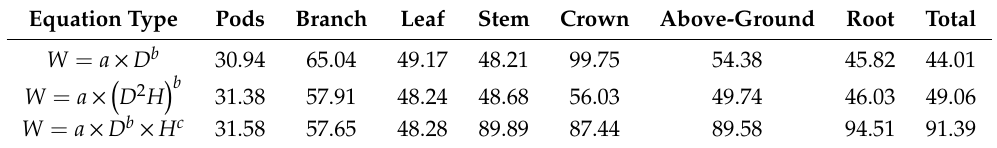
Table 2. Information statistic ( ∆ AICc) of the likelihood analysis for three allometric biomass equations. Equation Type Pods Branch Leaf Stem Crown